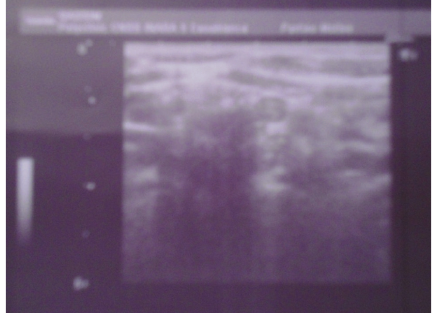
Figure 3: High resolution ultrasonography: isthmus and the left lobe were